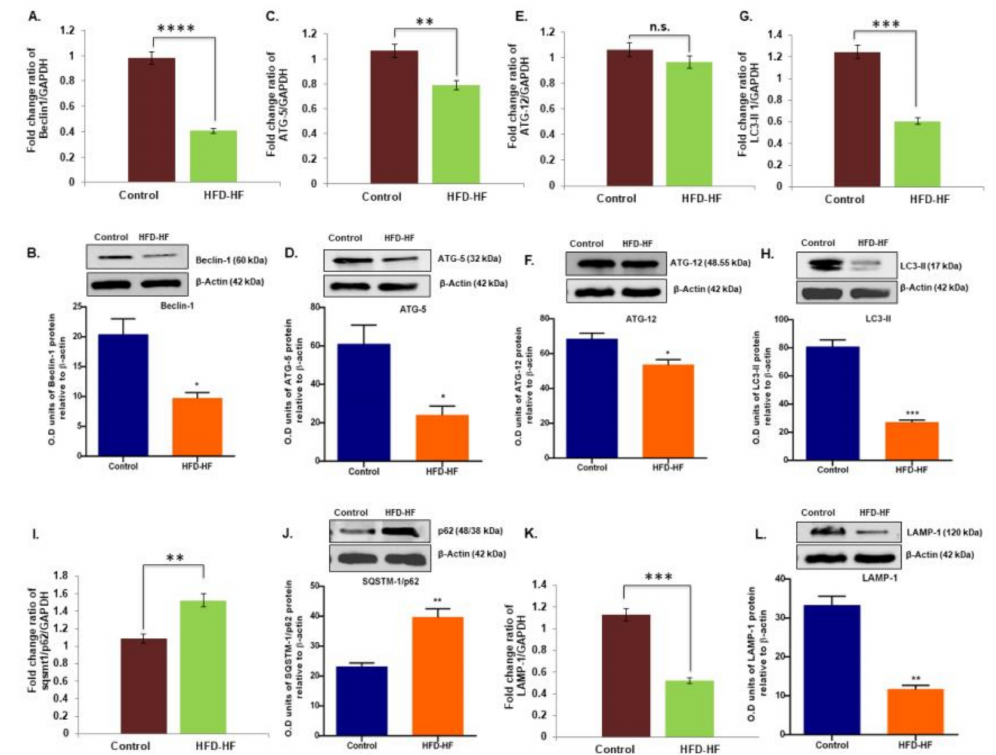
Figure 8. Effects of the HFD-HF diet on the mRNA and protein expression of Beclin-1 ( A , B ), ATG5 ( C , D ), ATG12 ( E , F ), LC3-II ( G , H ), SQSTM1/p62 ( I , J ), and LAMP1 ( K , L ), respectively, in the ovaries of adult rats. Bars with n.s. denote statistically insignificant differences between the respective means, while those with asterisk (*, **, ***, ****) denote statistically significant differences (* p ≤ 0.05, ** p ≤ 0.01, *** p ≤ 0.0001, **** p ≤ 0.0001 vs. control group) between the respective